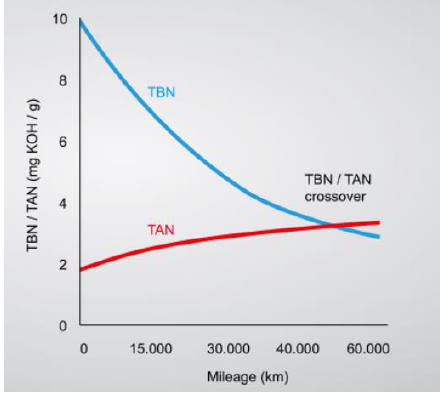
Fig. 1. Change in the value of TBN and TAN depending on the oil mileage